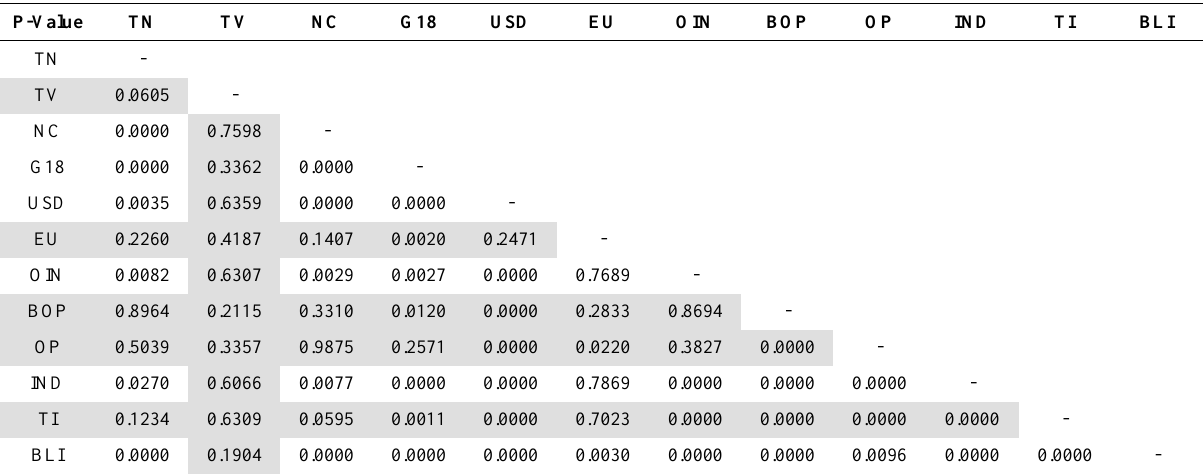
Table 5. P-Value for t-test between candidate